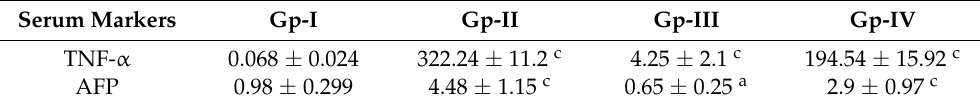
Table 3. Effect of A. gigantea leaf defatted methanolic extract on TNF- α and AFP relative expression in each animal group. Serum